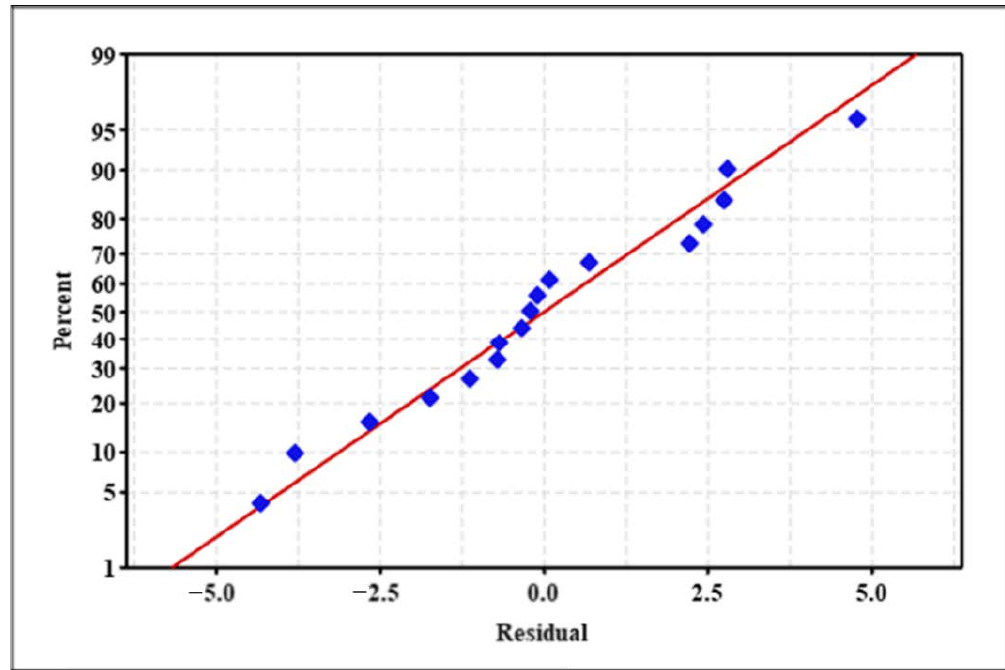
Figure 3. ( A ) Normal plot of the standardized e ff ects of the model parameters. ( B ) Half normal plot of